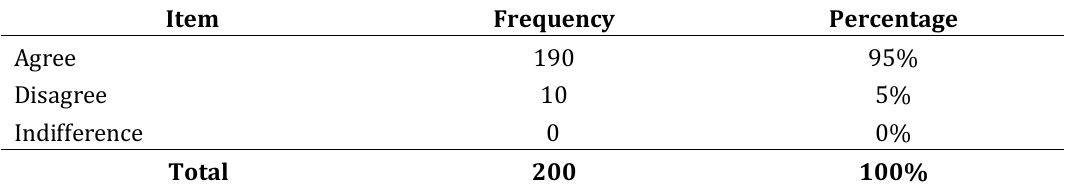
Agree that psychosocial care is importance for mothers with SCD Child